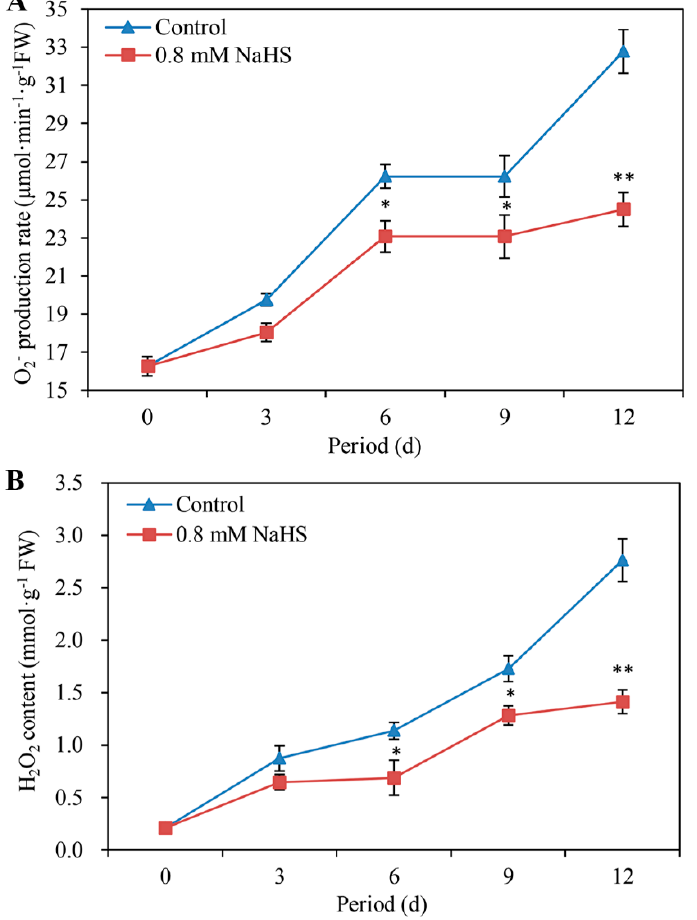
Figure 5. Changes in O 2 − production rate ( A ) and H 2 O 2 content ( B ) in Lanzhou lily scales with or without 0.8 mM NaHS treatment during storage at room temperature for 12 days. The error bars denote the standard errors ( n = 3). The asterisks denote Duncan’s multiple range test for significance: * p <0.05; ** p < 0.01. d: days.